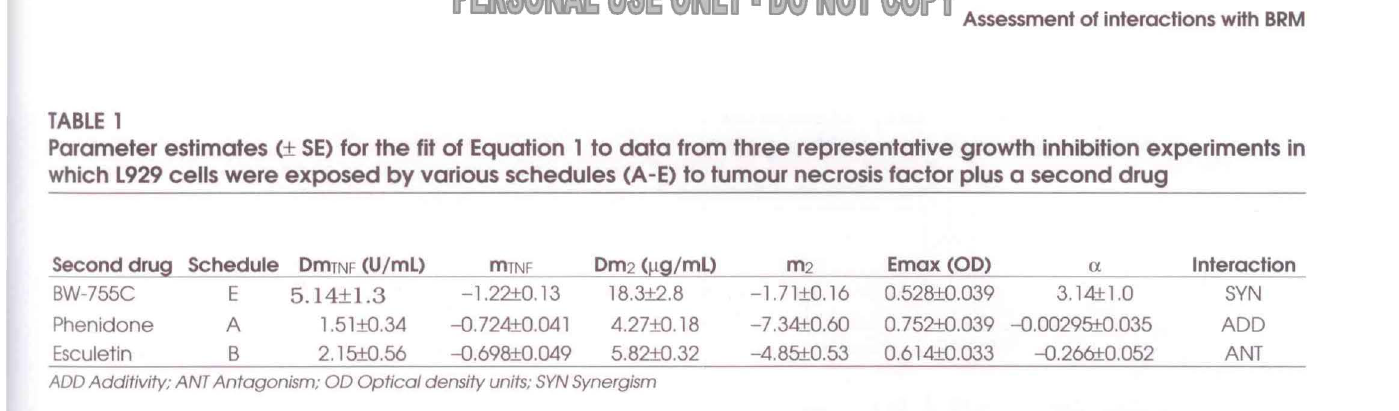
TABLE 1 Parameter estimates (± SE) for the fit of Equation 1 to data from three representative growth inhibition experiments in which L929 cells were exposed by various schedules (A-E) to tumour necrosis factor plus a second drug